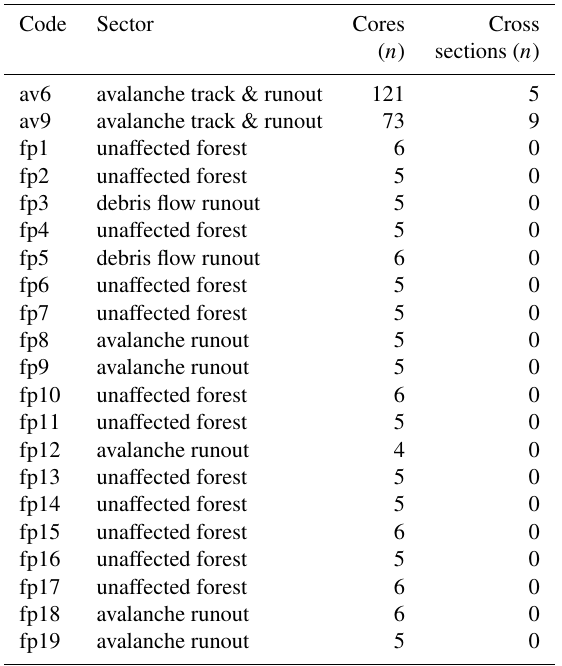
Table 1. Samples collected at different tracks and forest plots. Code Sector Cores Cross ( n